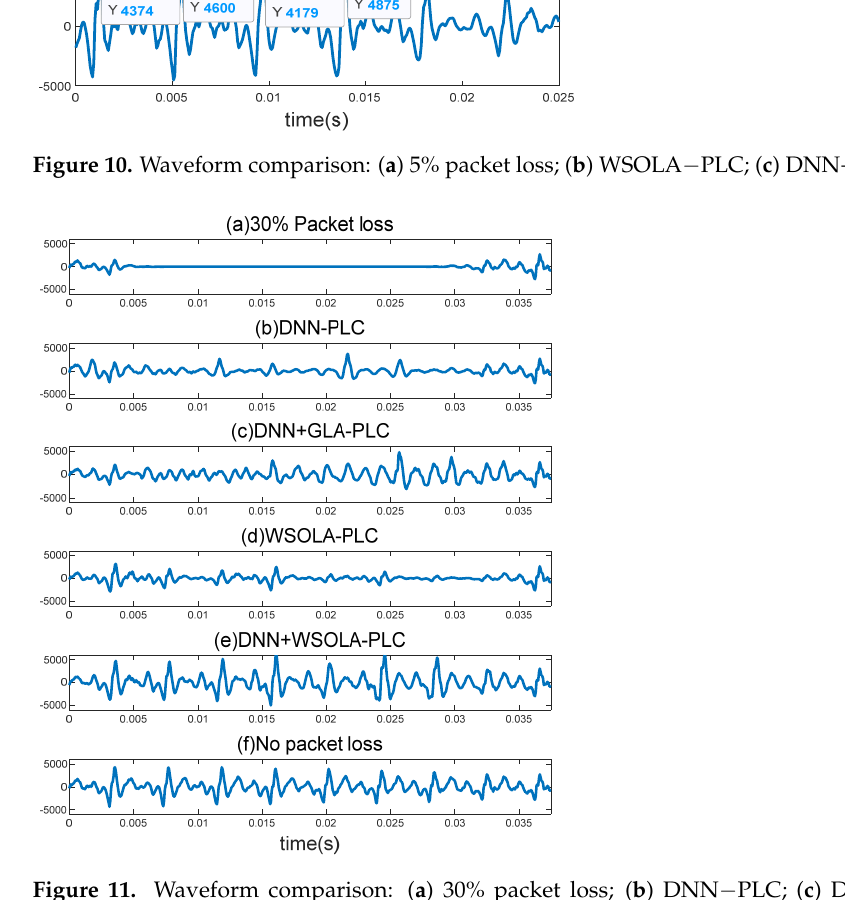
Table 1. PESQ results.